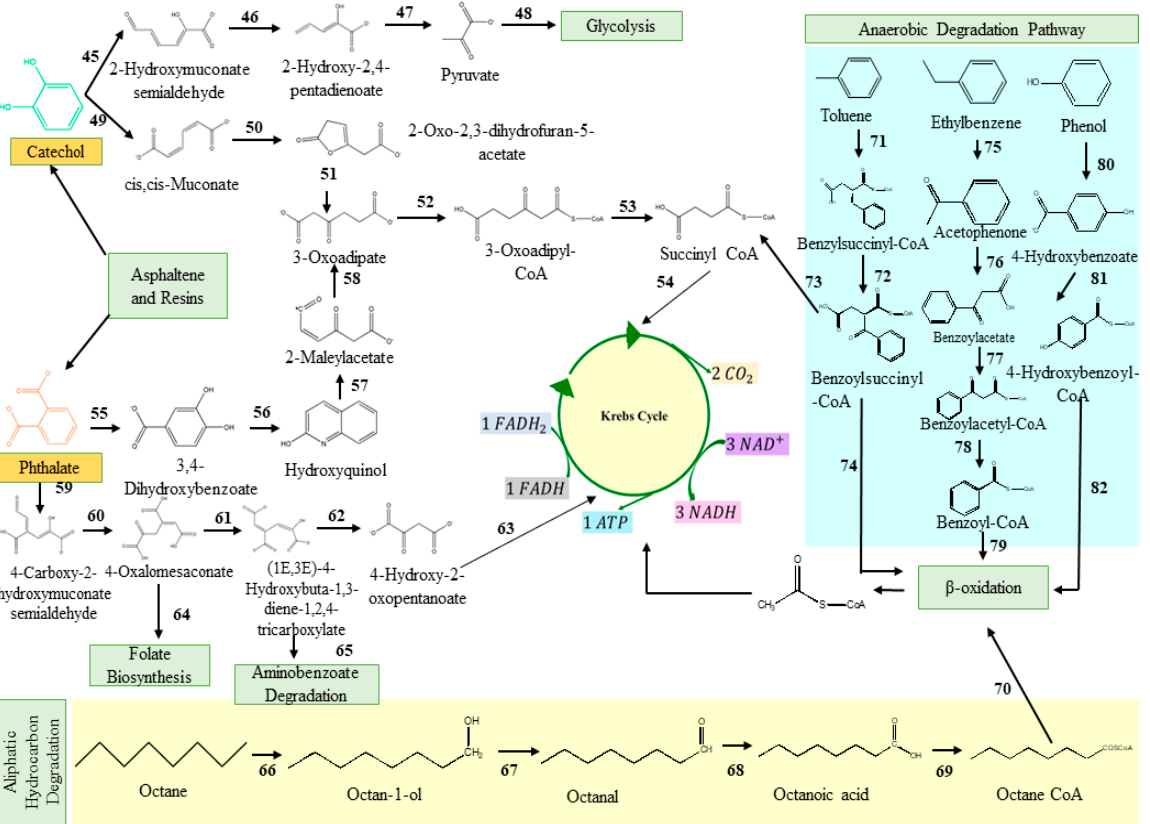
Figure 2. Terminal degradation steps of PAHs following benzoate degradation pathway via catechol and phthalate intermediates. Aliphatic hydrocarbon degradation pathway and anaerobic degradation pathway were also given in separate colour, with both ultimately joining the common car- bon metabolism pathway. The numbers representing specific enzymes viz 45. catechol 2,3-dioxy- genase 46. 2-hydroxymuconate-semialdehyde hydrolase 47. 4-hydroxy 2-oxovalerate aldolase 48. Common carbon pathway’s enzymes 49. catechol 1,2-dioxygenase 50. muconolactone D-isomerase;